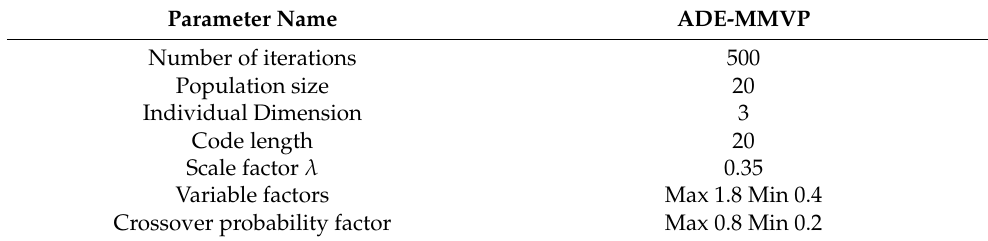
Table 1. Parameter